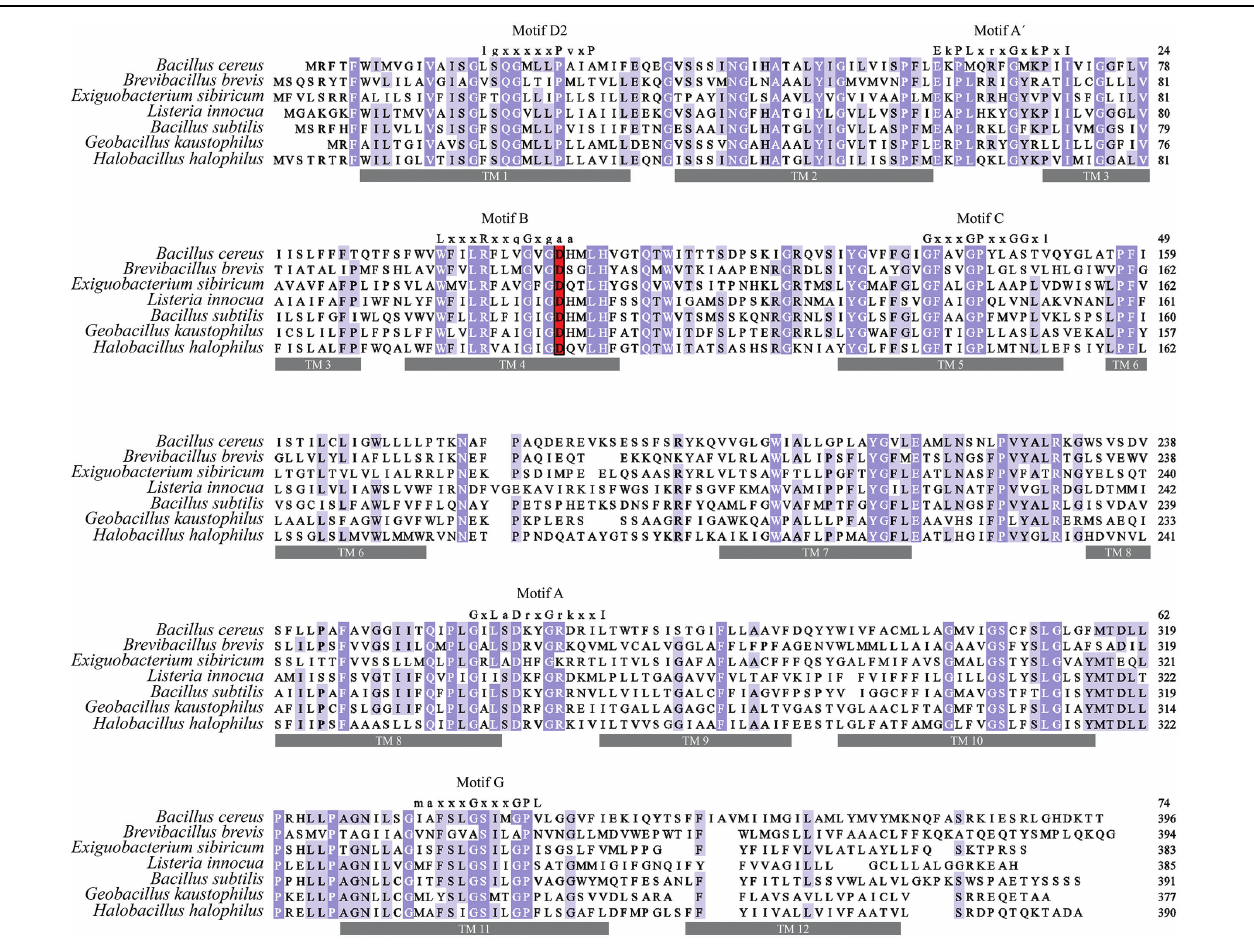
FIGURE 5 | Multiple sequence alignment of BC3310 and its homologs. BC3310 from B. cereus ATCC 14579 (UniProt accession number: Q81B77) was aligned using MUSCLE with orthologs from Brevibacillus brevis (C0ZL32), Exiguobacterium sibiricum (B1YK36), Listeria innocua (Q92AX8), B. subtilis (O34929), Geobacillus kaustophilus (Q5L2X3) and Halobacillus halophilus (I0JJA0). Shading corresponds to > 80% (dark blue), > 60% (blue), > 40% (light blue), and ≤ 40% (white) amino acid identity, respectively. The conserved acidic residue in transmembrane region 4 is displayed in red. Transmembrane regions have gray bars under and conserved MFS motifs are depicted above the